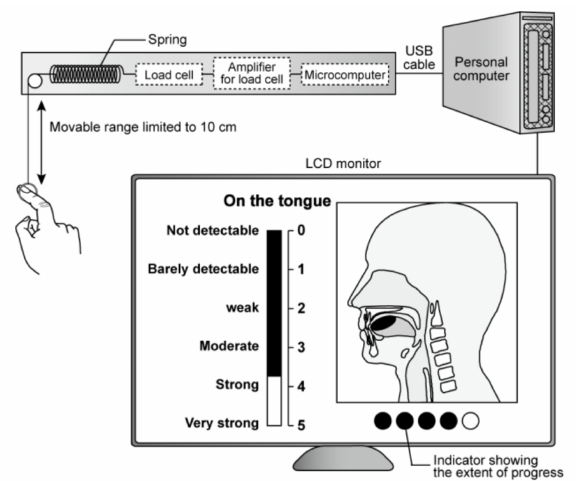
Figure 1. Outline of the time–intensity evaluation system. Participants evaluated perceived intensity by operating a pull-ring, which was a component of the evaluation system. The movable range of the ring was limited to 10 cm by a stopper. Positional information of the ring, synonymous with spring tension, was measured by a load cell, with output expressed as voltage. After the output voltage was amplified, it was subjected to analog-to-digital (A/D) conversion on a microprocessor at a frequency of 1 kHz. Average voltage was calculated in time windows of 50 milliseconds, and then output to a personal computer via a serial port as a digital value corresponding to a six-point magnitude scale of perceived intensity. To provide visual feedback in real time, the value of perceived intensity was displayed on a liquid crystal display (LCD) monitor as a black bar on a six-point magnitude scale (0: “not detectable” to 5: “very strong”). Furthermore, to inform the participant of the time remaining in the evaluation, an indicator of the extent of progress was shown on the